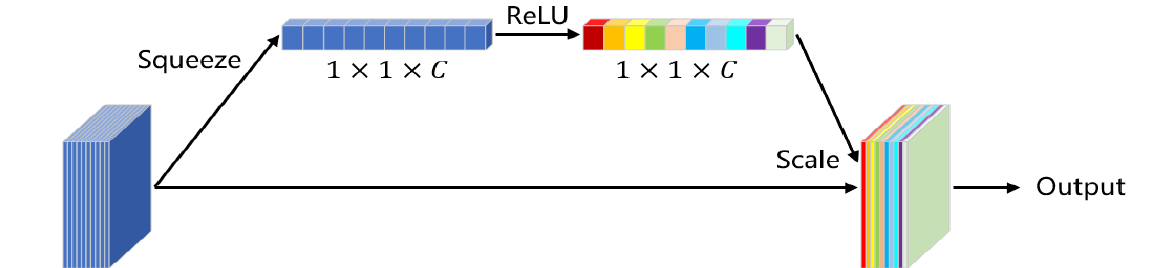
Figure 4. Structure of SE block.